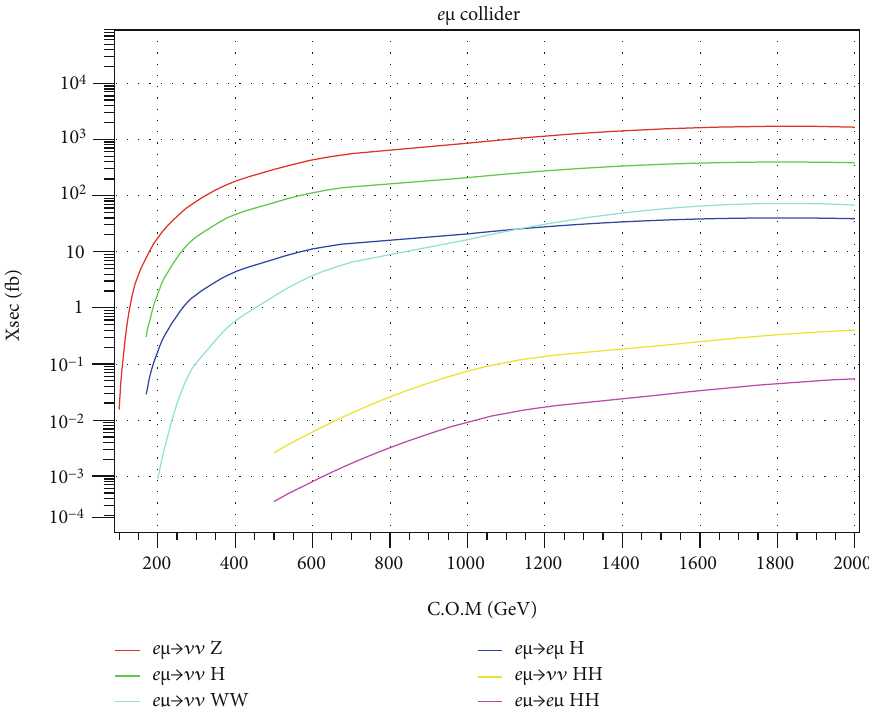
Figure 1: Cross-section dependence on center-of-mass energy of six dominant physics processes at an electron-muon collider.